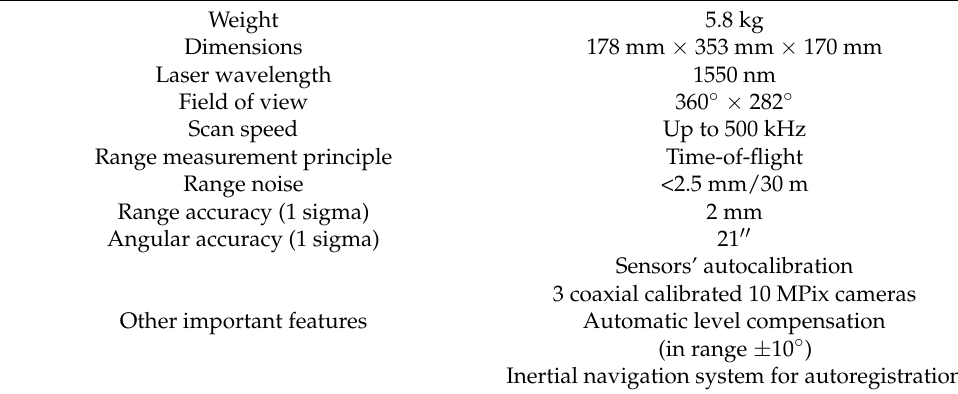
Table A4. Basic characteristics of Trimble X7 3D scanner.